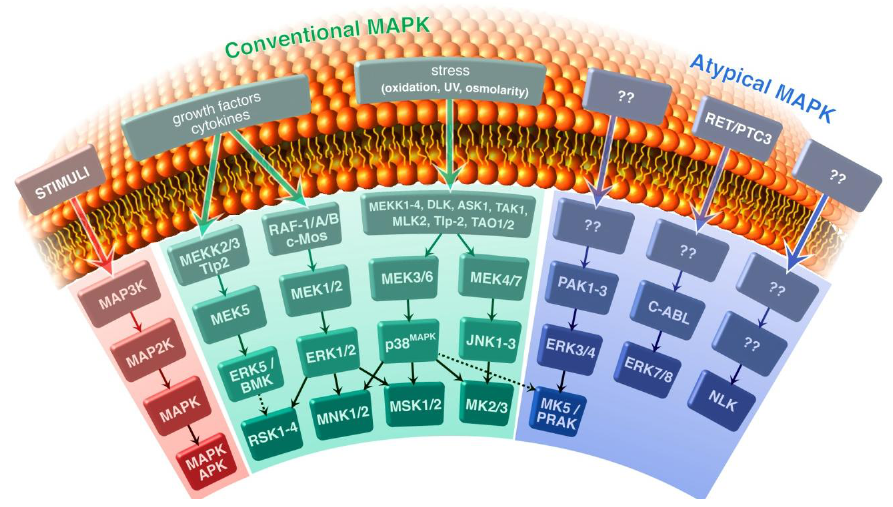
Figure 1. Schematic presentation of the mammalian mitogen-activated protein kinase (MAPK) pathways. The conventional MAPK pathways, represented by MAPK/extracellular signal regulated kinase kinase (MEK), extracellular signal-regulated kinases (ERK), c-Jun N-terminal kinases (JNK), p38 MAPK , and MEK5/ERK5 and the atypical MAPK pathways, including ERK3, ERK4, ERK7, ERK8, and Nemo-like kinase (NLK) are shown. The typical MAPK pathways consist of a module of three kinases that subsequently phosphorylate and activate each other: MAPK kinase kinase (MAP3K) phosphorylates MAPK kinase (MAP2K), which in turn phosphorylates MAPK. The MAPKs ERK1, ERK2 and ERK5 are typically activated by growth factors, while p38MAPK and JNK are predominantly induced by a variety of environmental stresses. JNK can also be activated by mitogens and pro-survival stimuli. Downstream of MAPK are substrates including other protein kinases referred to as MAPK-activated protein kinases (MAPKAPK). The MAPKAPK MK5/PRAK is target for the conventional p38 MAPK and the atypical ERK3/4